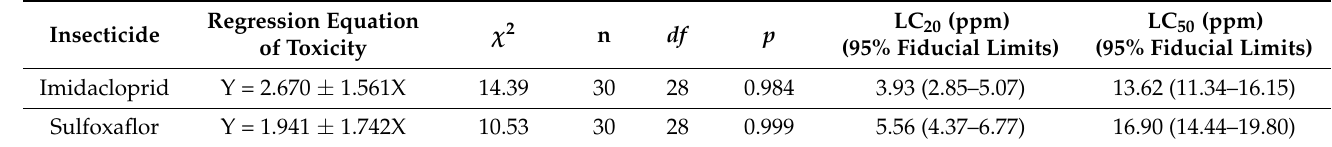
Table 2. Baseline toxicity results following contact exposure of two insecticides against Aphis gossypii adults. Regression Insecticide